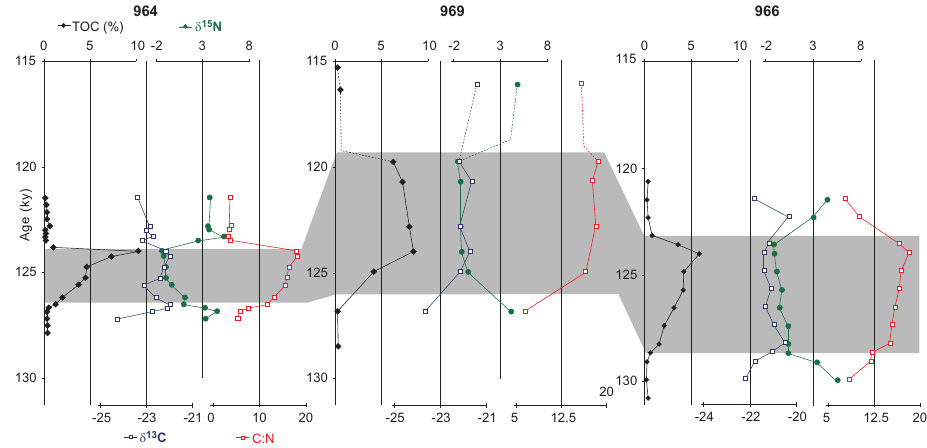
Fig. 8. TOC, C and N ratio, d 15 N, d 13 C for S5 at three studied sites. Shaded area corresponds to organic enriched sediments